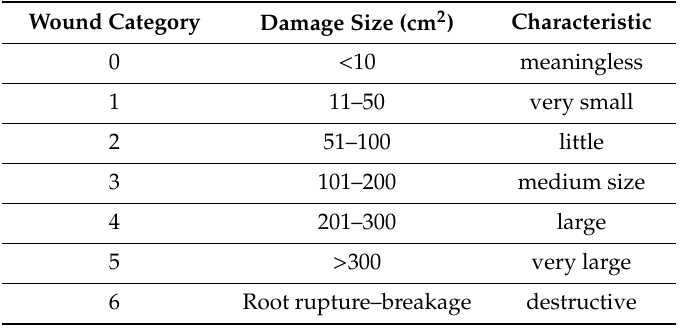
Table 4. Classification of wounds based on the wound size [29].